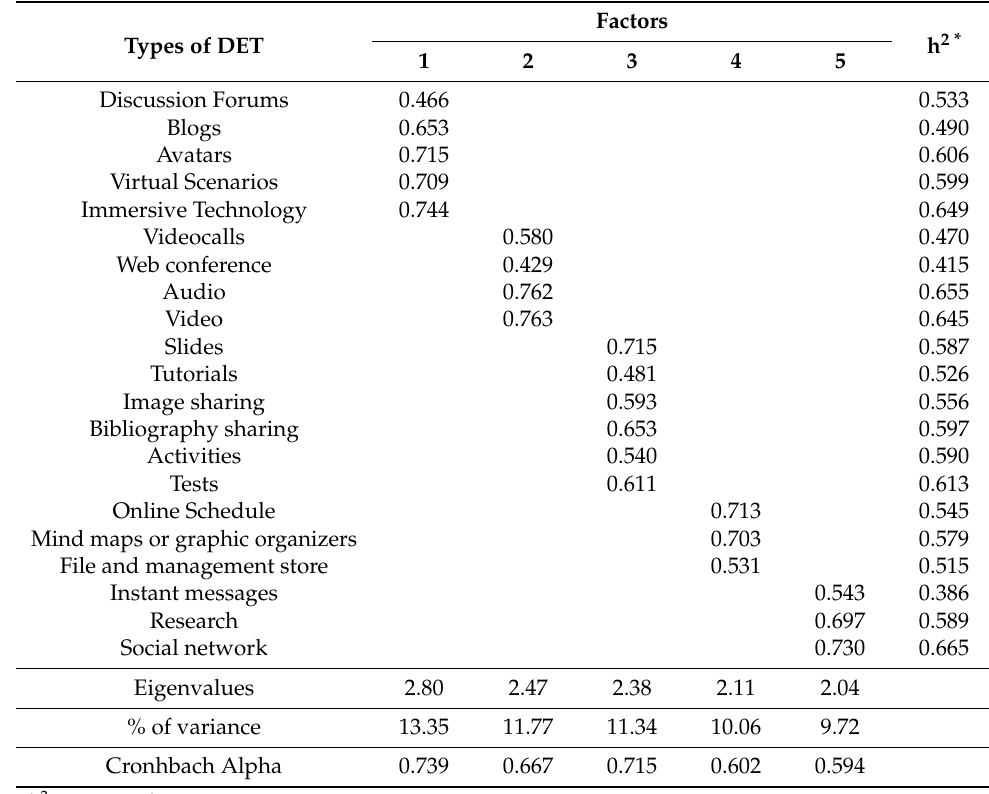
Table 1. Exploratory factorial analysis for types of